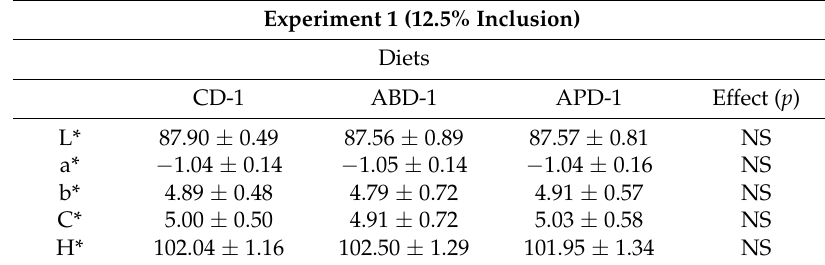
Table 7. Color properties (CIELAB) of milk from Murciano-Granadina goats fed on diets containing or not containing artichoke by-products (plant and outer bracts) in Experiment 1 (12.5% inclusion) and Experiment 2 (25%